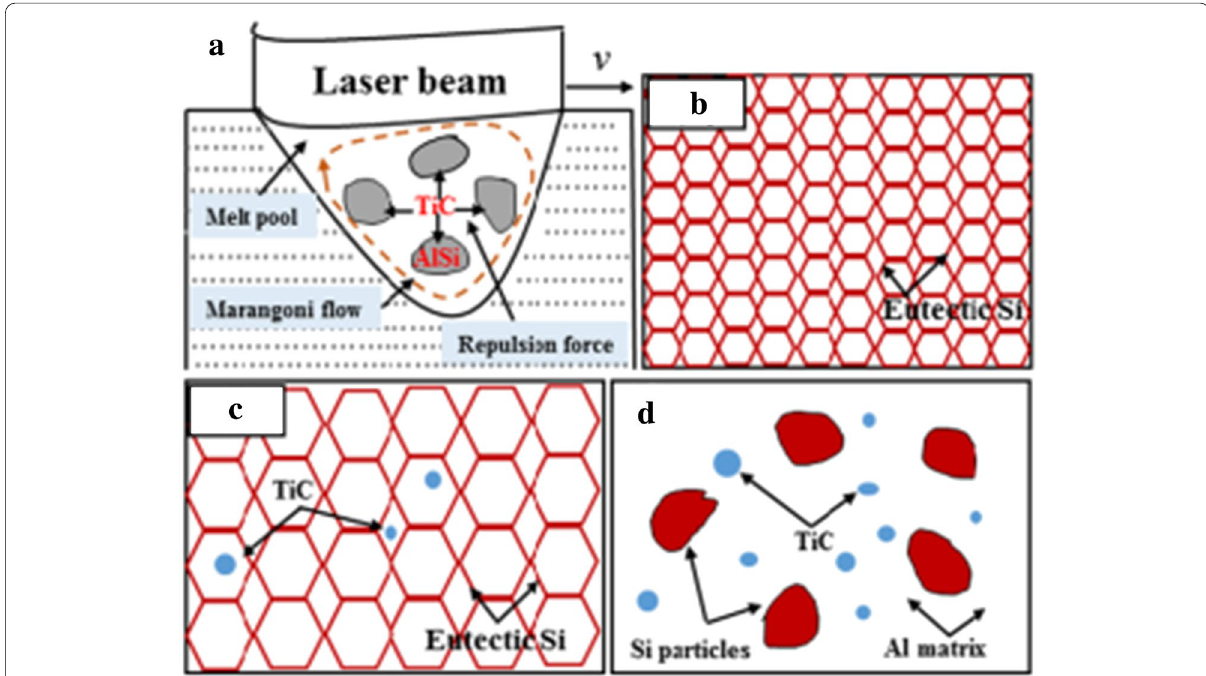
Figure 1 a The schematic describing the formation mechanism of Al-15Si/TiC structure, b Al-15Si, c Al-15Si/1.0-2.5 wt% TiC, d Al-15Si/10 wt%